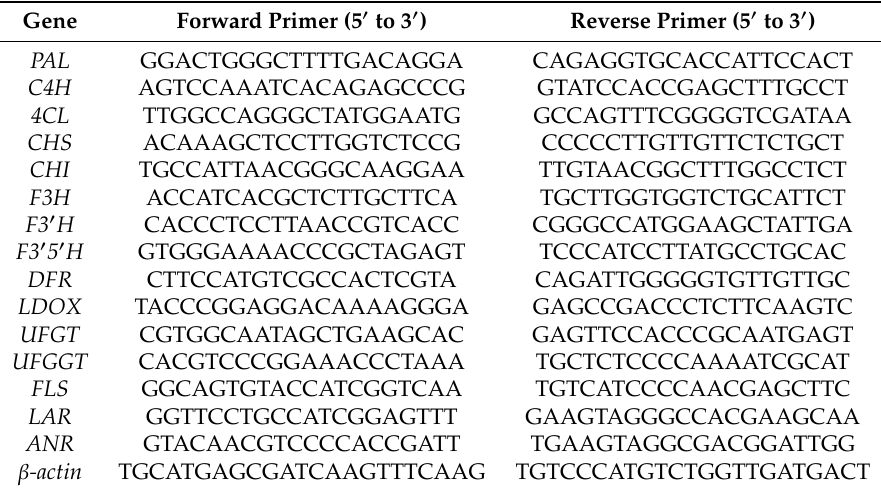
Table 1. Primers used for